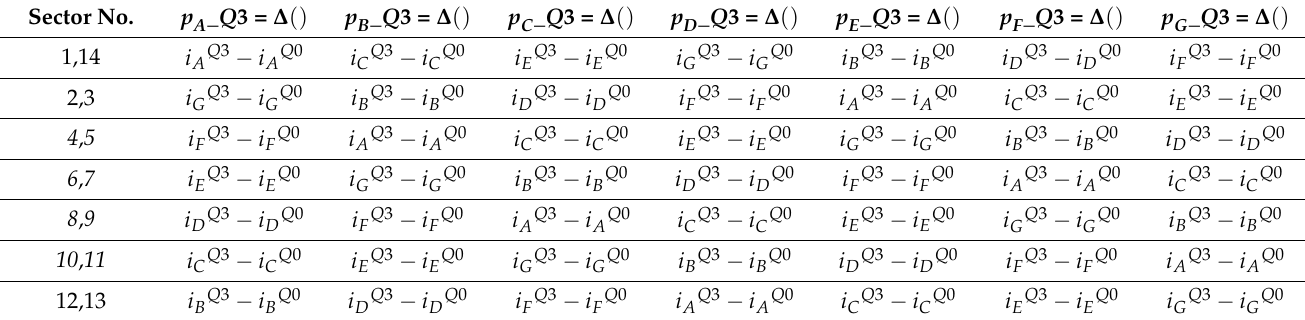
Table 5. Saliency position scalars in each sector of the seven-phase PMSM using Q3 (case=2). Sector No.